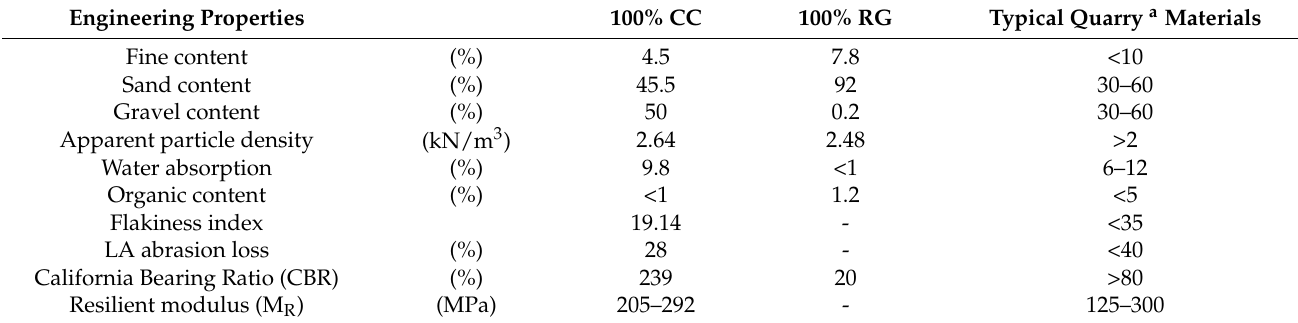
Table 1. Geotechnical properties of the parent materials.